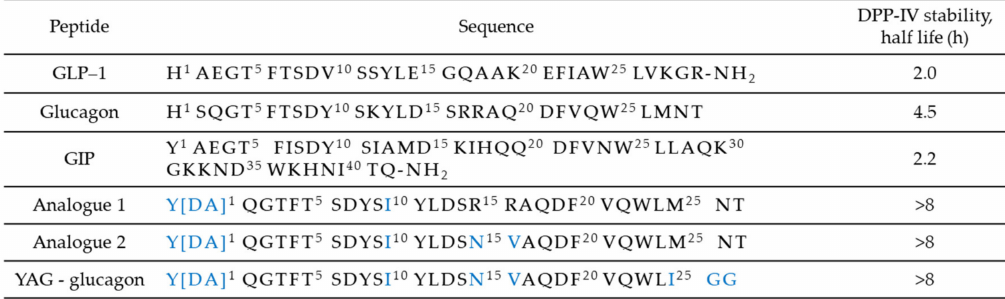
Figure 7. Amino acid sequences of glucagon, the incretin hormones, and